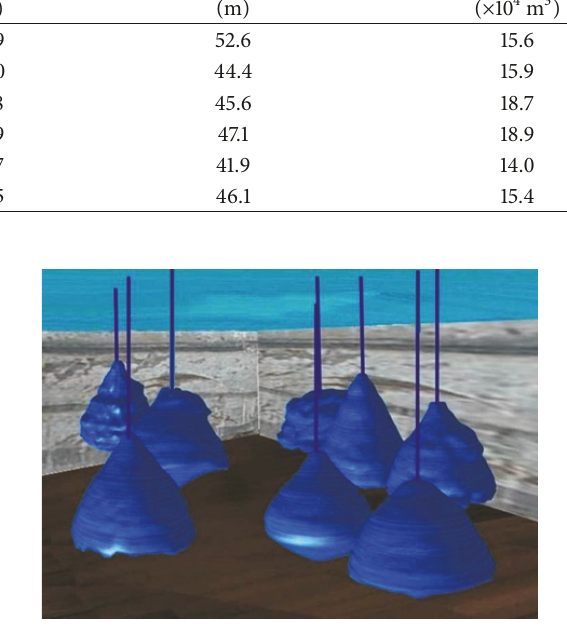
Figure 5: Sonar surveys of several existing salt